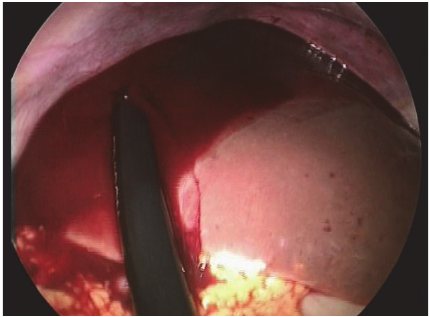
Figure 3: Diagnostic laparoscopy: identification of active arterial bleeding by topography of the left uterine